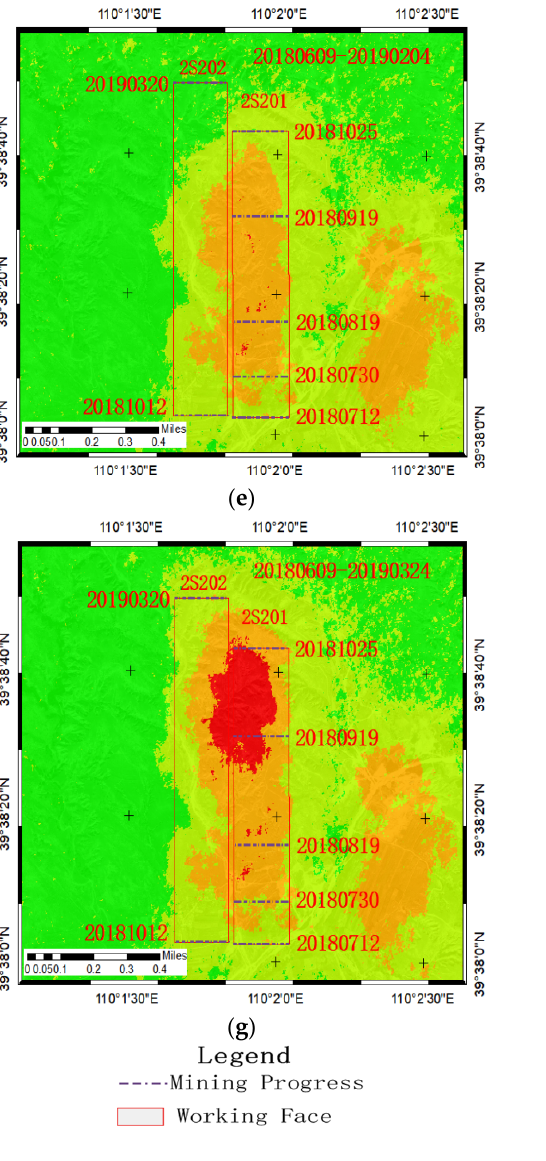
Figure 10. ( a – h ) are respectively the accumulated settlement maps of DInSAR.